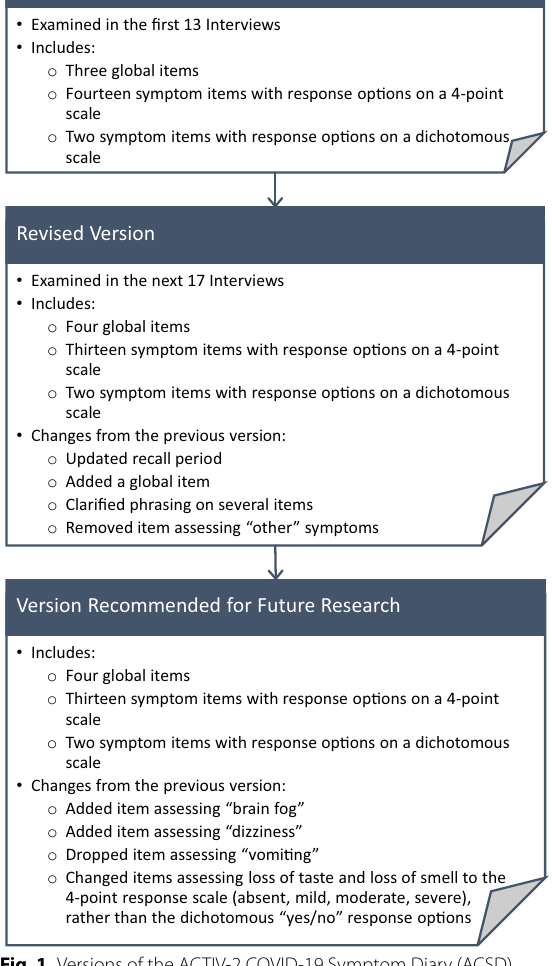
Fig. 1 Versions of the ACTIV-2 COVID-19 Symptom Diary